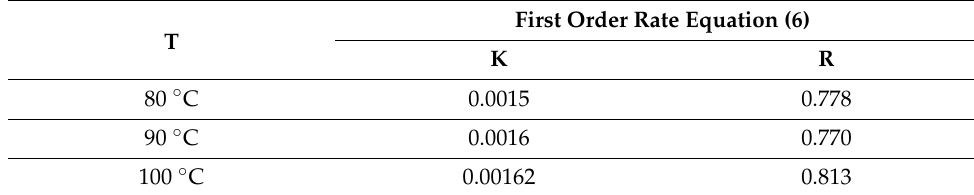
Table 2. Rate constants and regression